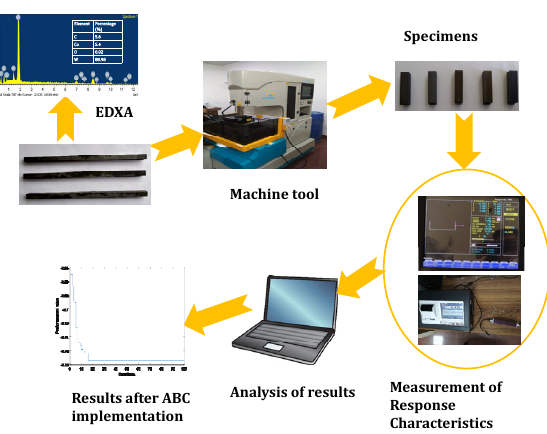
Figure 2. Sequence of tasks performed in the present work 3.